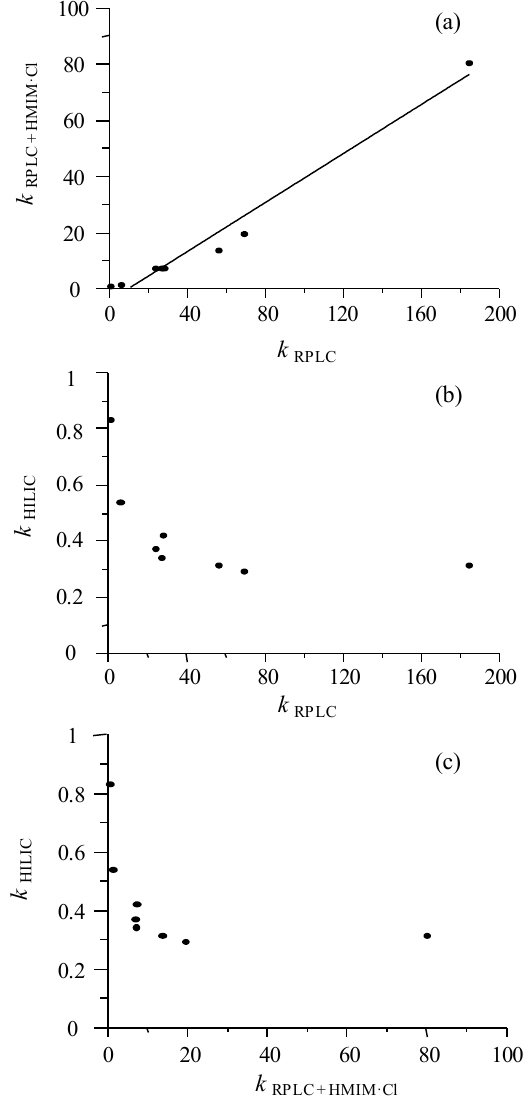
Figure 2. Comparison of selectivity for: ( a ) RPLC without additive vs. RPLC with [C 6 C 1 im]Cl, ( b ) RPLC without additive vs. HILIC, and ( c ) RPLC with [C 6 C 1 im]Cl vs. HILIC. Retention factors correspond to a mobile phase containing 10% modifier (acetonitrile in RPLC and water in HILIC).